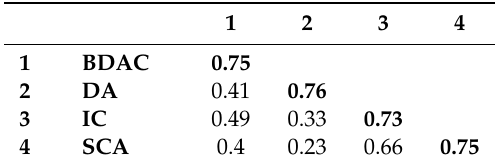
Table 3. Discriminant validity check (square root of the AVE, shown on the diagonal in bold).